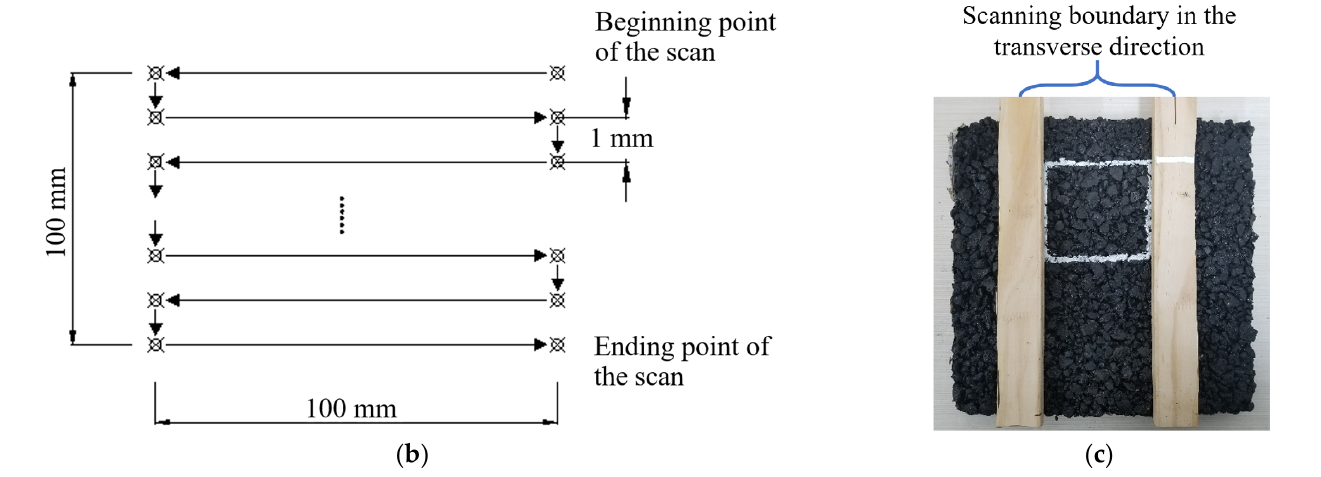
Figure 3. Laser scanning of asphalt pavement profile. ( a ) Basic configuration of laser scanner; ( b ) scanning path; ( c ) scanning region of texture.